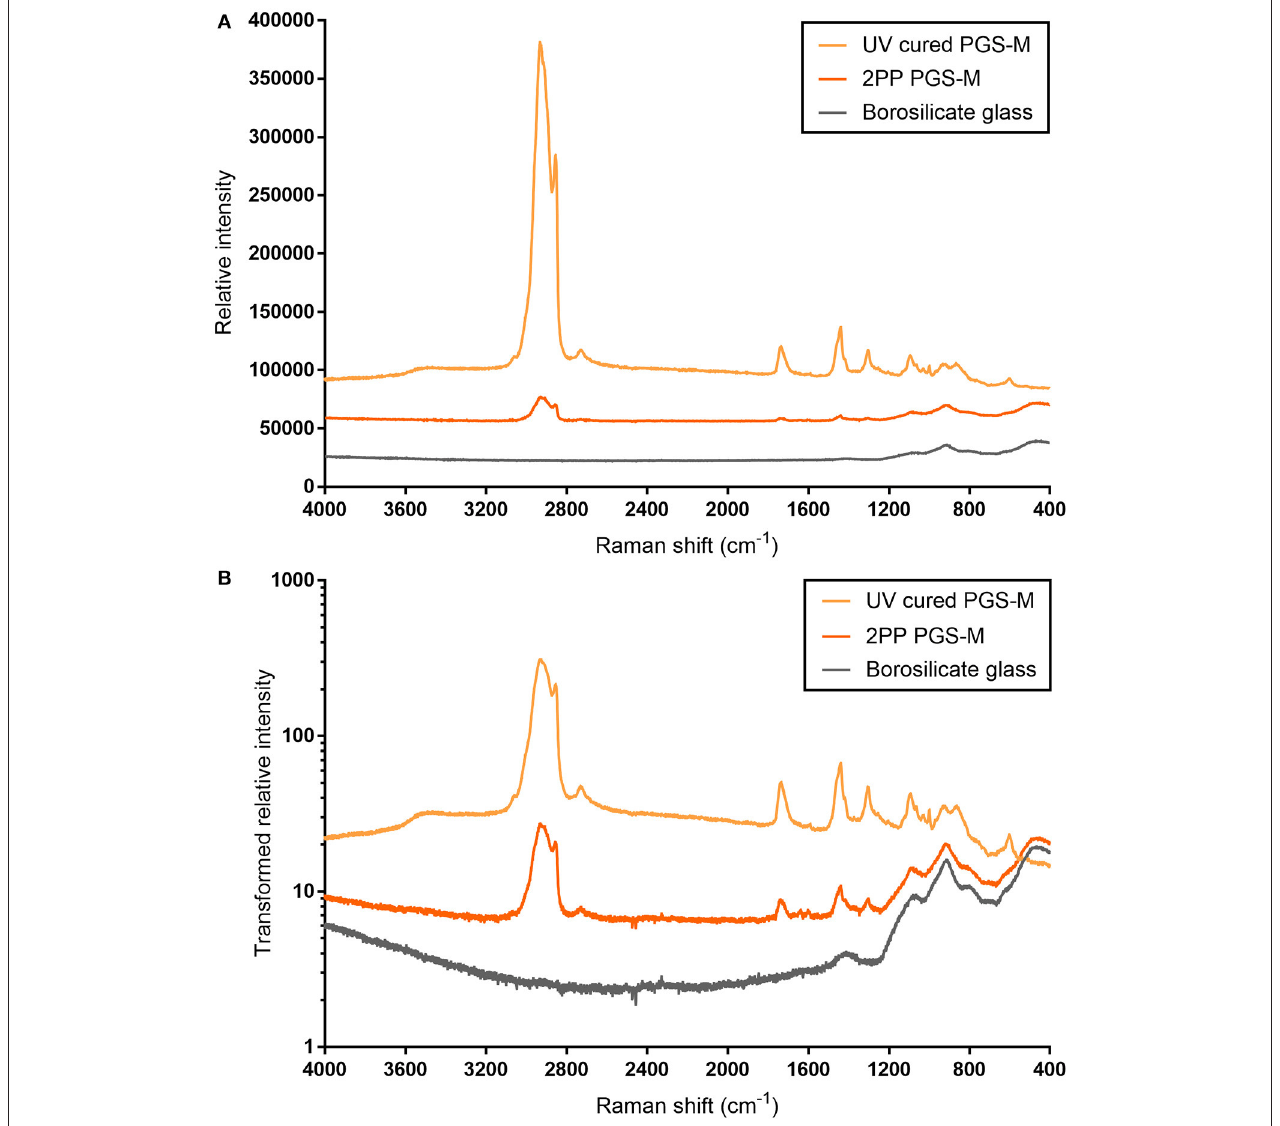
FIGURE 12 | Raman spectra for 50% Low M w PGS-M photocured as 3D scaffolds, using 2PP, and as disks, using a UV lamp. The spectra for the underlying borosilicate glass slides, onto which the 3D scaffolds were adhered to, is also presented. The original data (A) show the spectra for both PGS-M samples are distinctly different from that of borosilicate glass. The peak intensity values produced by the UV cured PGS-M disks are higher than those of the 3D scaffolds. Transforming the data (relative intensity/1000 and presented on a logarithmic scale) allows the similarities of the PGS-M spectra to be more easily visualized, with peaks clearly visible at equal Raman shift values (B)